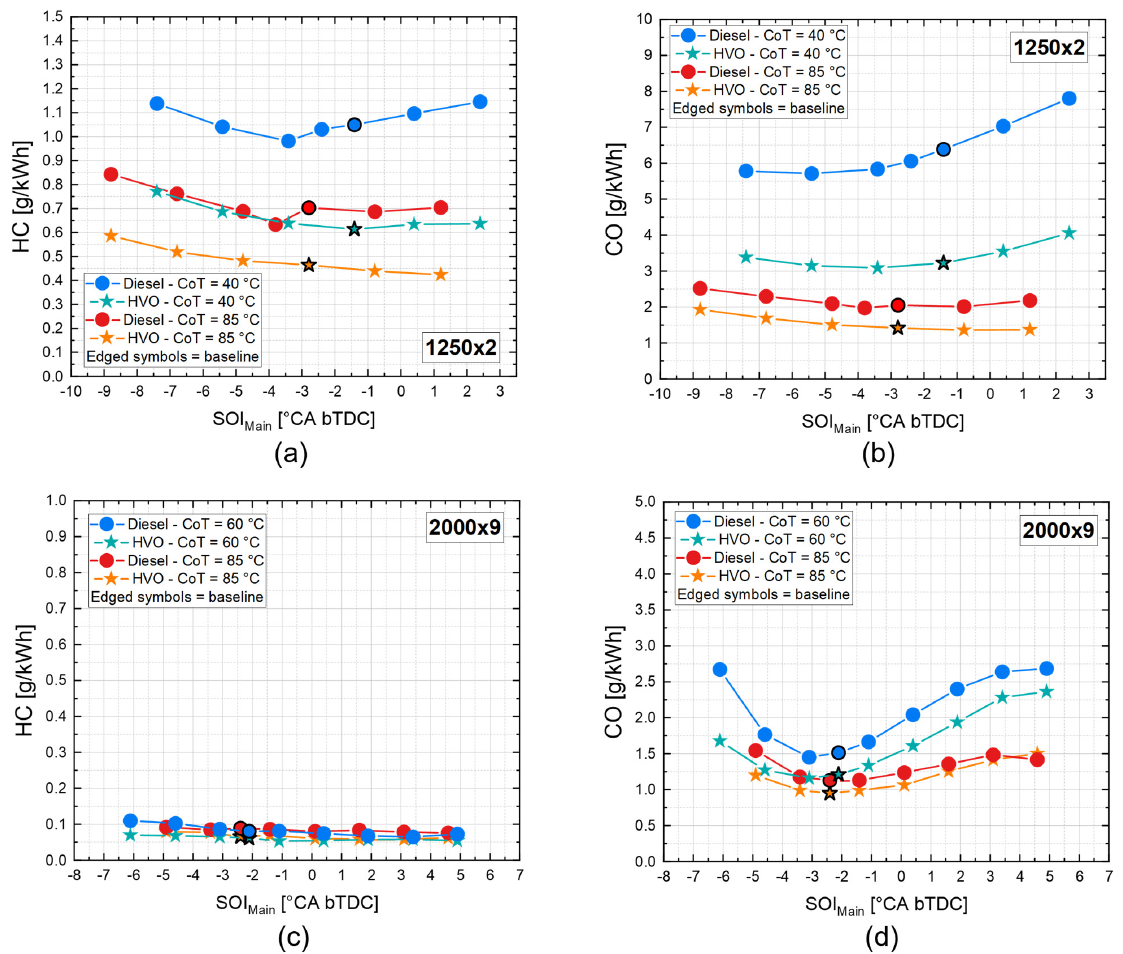
Figure 7. Engine-out HC and CO emissions along SOI Main sweep tests at 1250 × 2 ( a , b ) and 2000 × 9 ( c , d ). Comparison between diesel and HVO at high and low coolant temperatures. Warm colors (red and orange) represent high coolant temperatures, while cool colors (blue and cyan) represent low coolant temperatures. Circles represent diesel, while stars represent HVO.